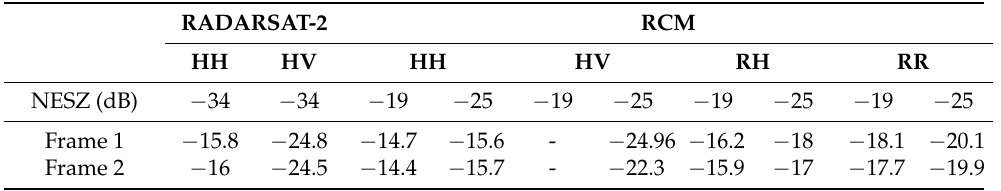
Table 3. Threshold value and the corresponding extracted water extents using different polarizations over the Bay of Quinte, the thresholds and water extents are calculated using a FQ17W image acquired on 27 April